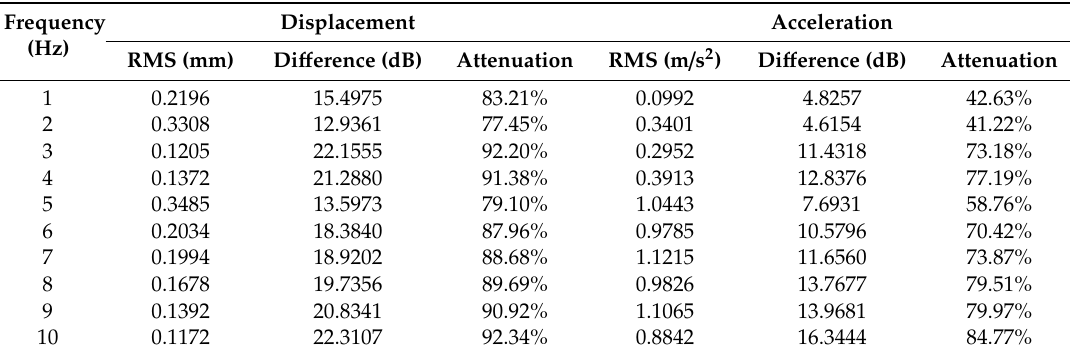
control of the pipeline is controlled by the SMVS vibration control, the statistical results of the vibration response of the pipeline under di ff erent excitation frequencies are shown in Table